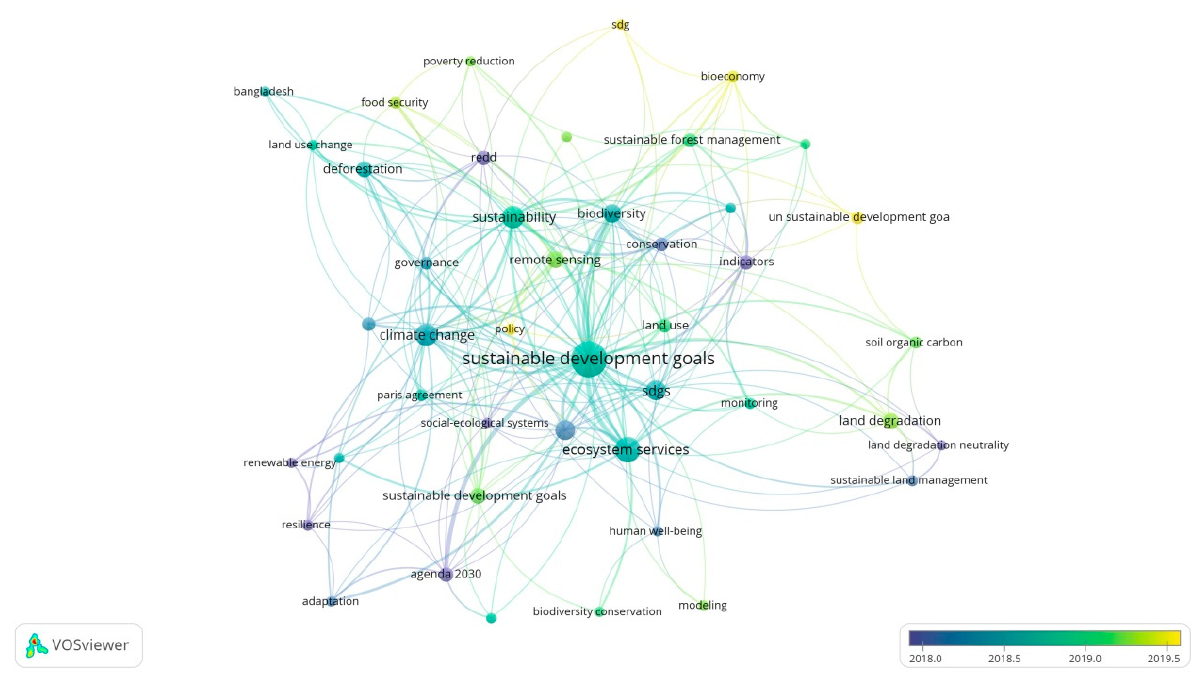
Figure 9. Keywords co-occurrence timeline view. The size of each keyword (node) represents the number of occurrences in the documents analyzed. Colors represent different clusters. The color represents the year when the keyword first appeared, and the color from blue to yellow represents early to late.